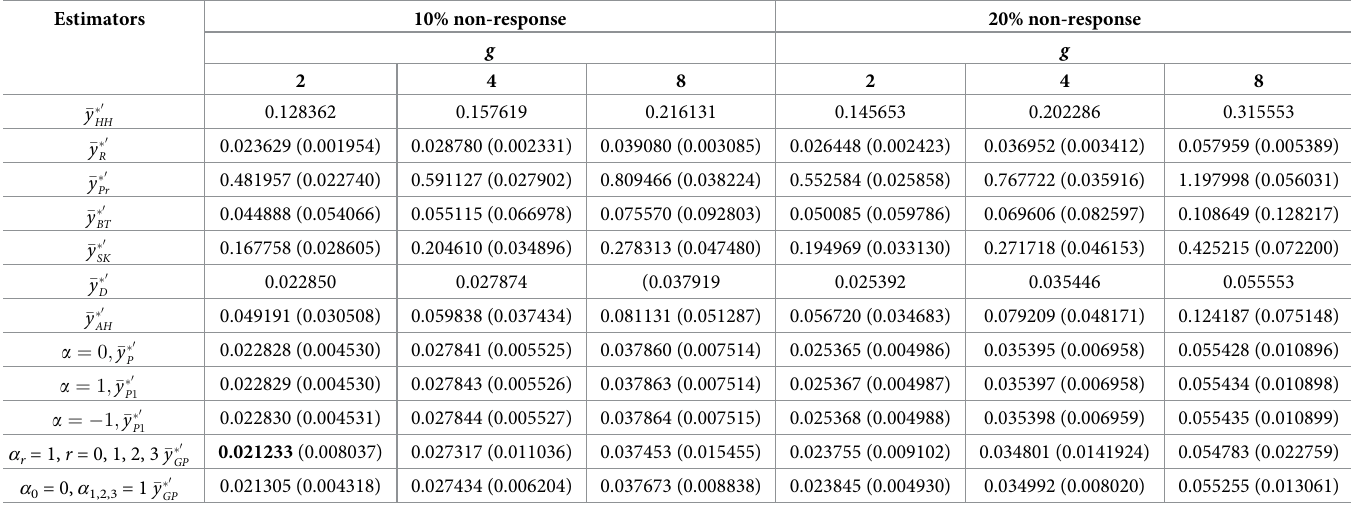
Table 2. Mean squared error and | Bias | (in brackets) values for different estimators for Population I with measurement error.